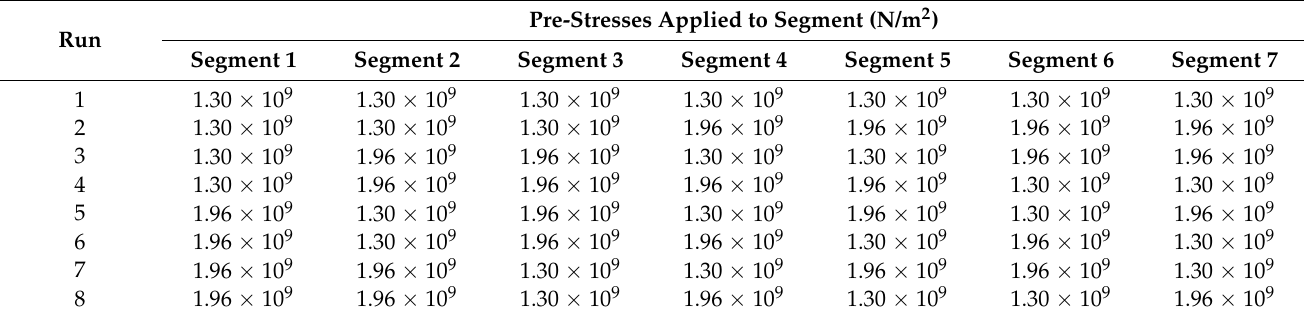
Table A1. Sample points based on seven-factor two-level orthogonal experimental design. Pre-Stresses Applied to Segment (N/m 2 Run